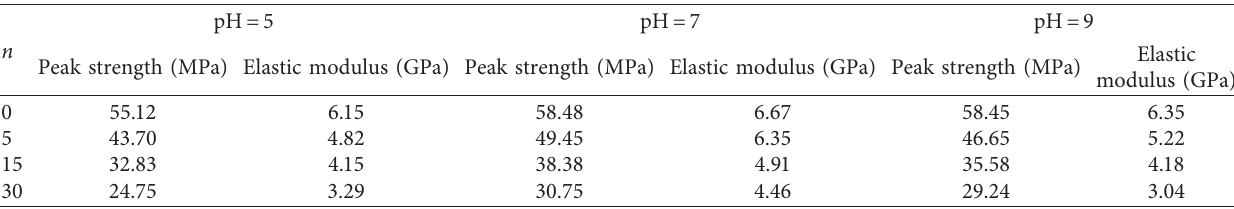
Table 1: Uniaxial compression test